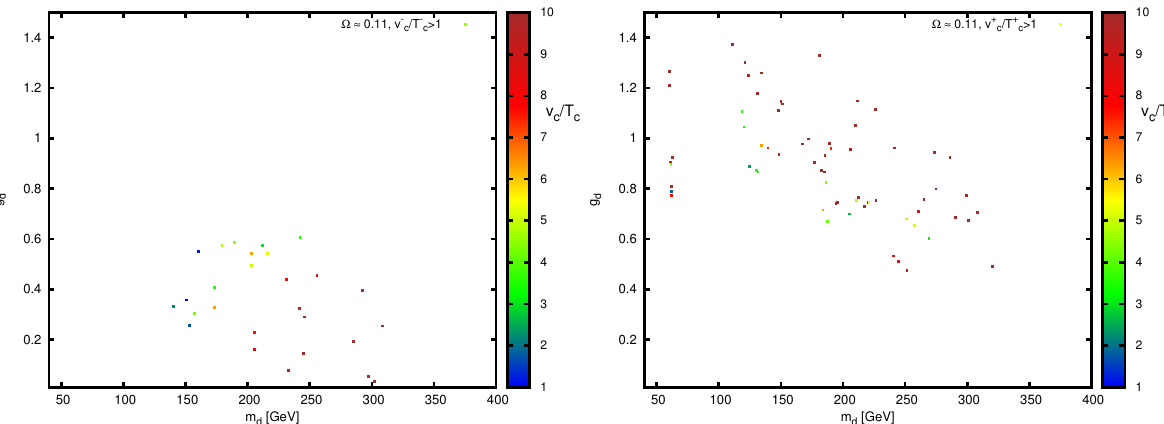
Figure 1 . The allowed DM mass, m d , against the Yukawa coupling, g d , in the fermionic dark matter scenario with pseudoscalar mediator, bounded from the relic density and (cid:12)rst-order phase transition conditions for left) v (cid:0) =T (cid:0) > 1 with DM mass in the range 140{310 GeV right) v + c c DM mass in the range 60{320